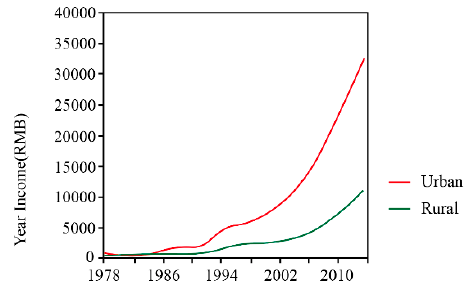
Figure 2. Urban and rural income.